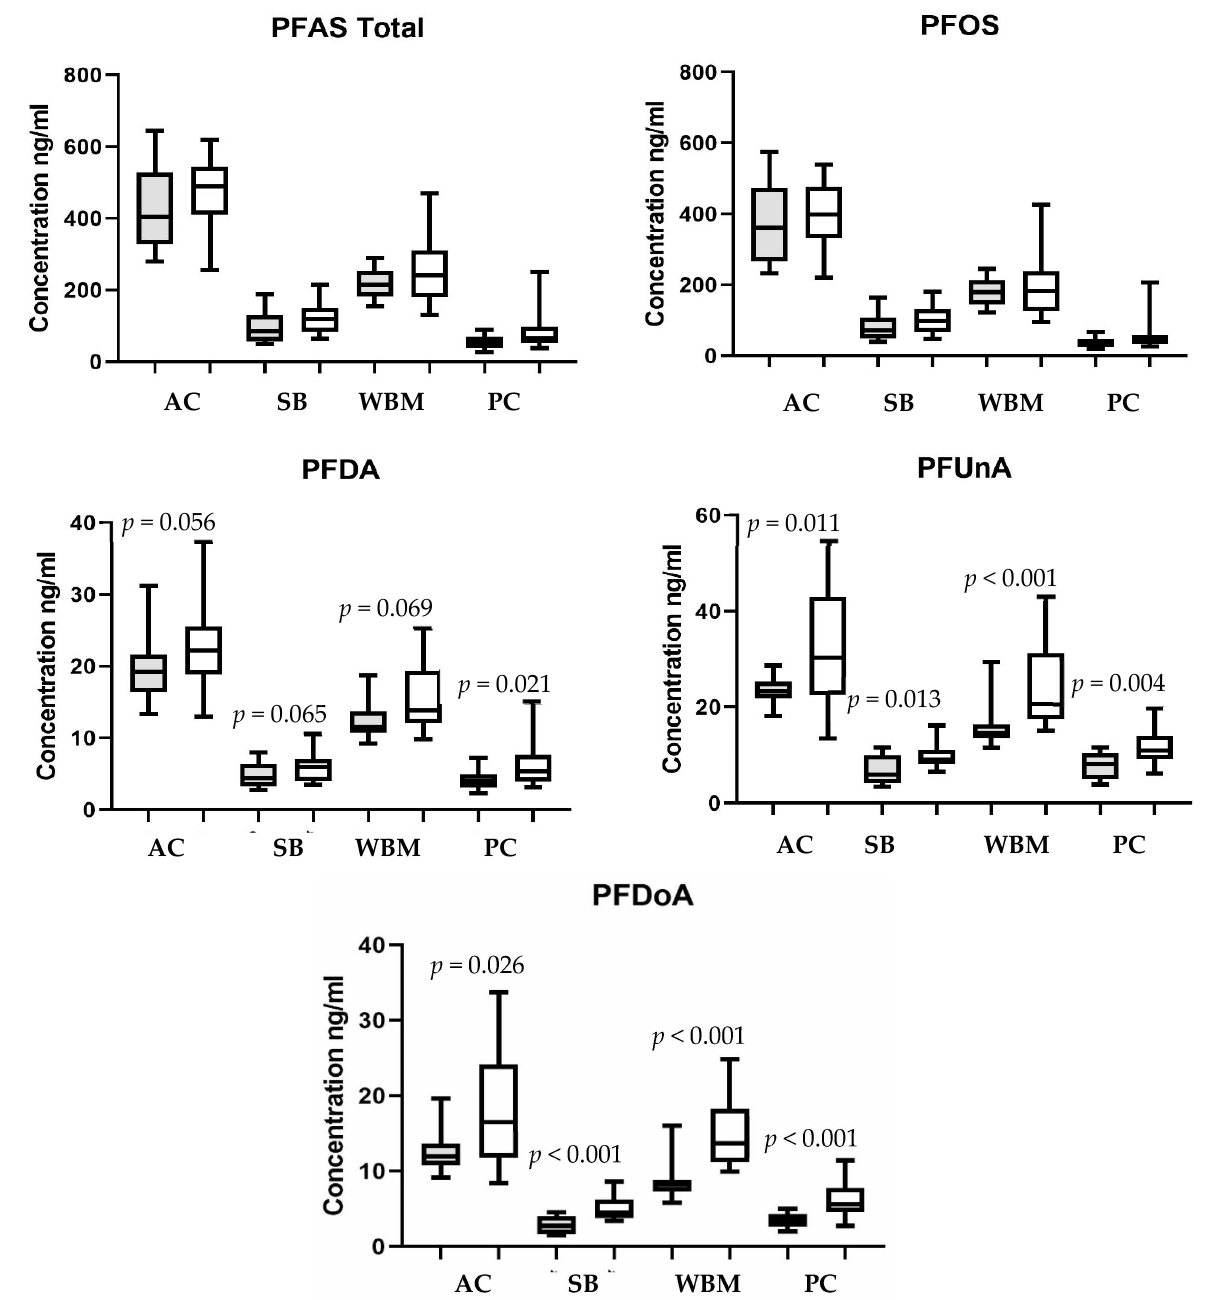
Figure 2. Comparison of perfluoroalkyl substances in female (gray bars) and male (white bars) smallmouth bass plasma from the Antietam Creek (AC), South Branch Potomac (SB), West Branch Mahantango (WBM) and Pine Creek (PC) sites. p values indicate difference between male and female at that site. There were no significant differences at any sites for total PFAS or PFOS. Box plots show minimum and maximum values, the median, and interquartile